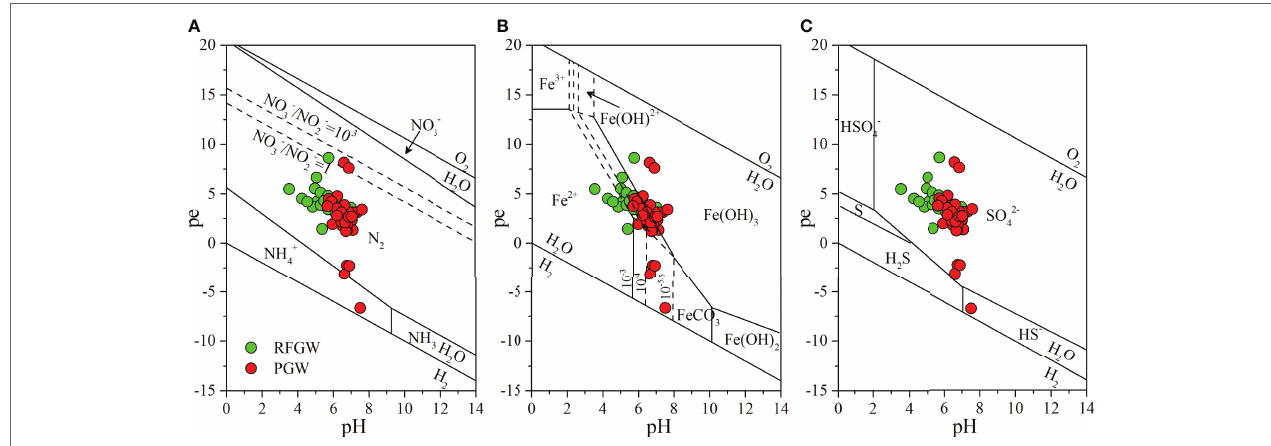
FIGURE 9 | Redox diagram of nitrogen (A) , iron (B) , and sulfur (C)